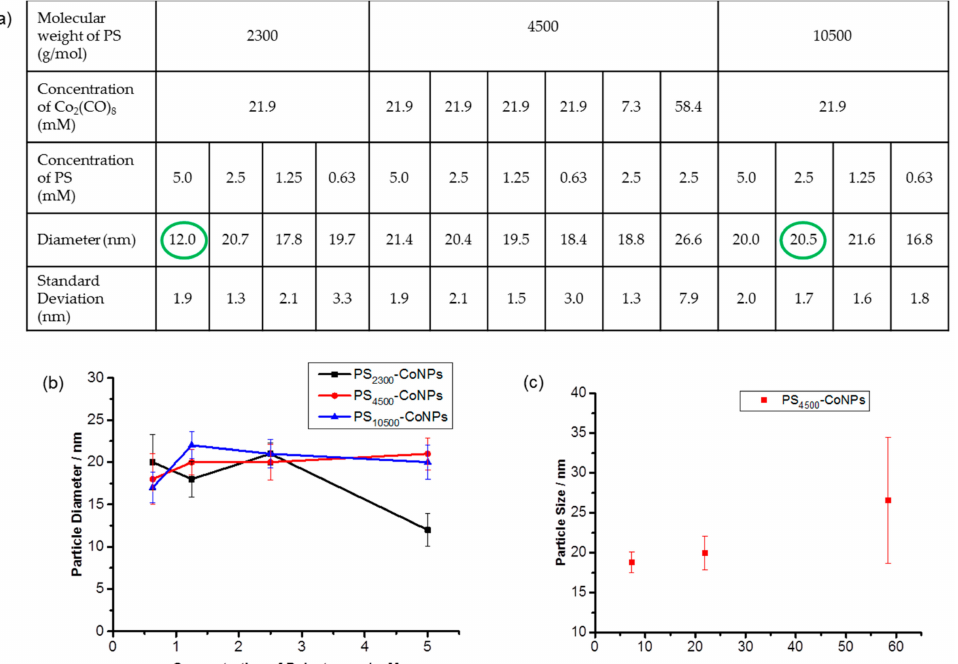
Figure 5. TEM images of PS–Co NPs synthesized with the concentration of cobalt carbonyl fixed at 21.9 mM, and only with different concentration of PS–NH 2 ( M n = 10,500 g/mol, C PS ): ( a , b ) C PS = 5 mM, D = 20.0 ± 2.0 nm; ( c , d ) C PS = 2.5 mM, D = 20.5 ± 1.7 nm; ( e , f ) C PS = 1.25 mM, D = 21.6 ± 1.6 nm; ( g , h ) C PS = 0.63 mM, D = 16.8 ± 1.8 nm. The PS–Co NPs dispersion in DCB was dropped on to the TEM grid. The mean size and standard deviation were obtained from a sample of around 200 NPs using ImageJ software.